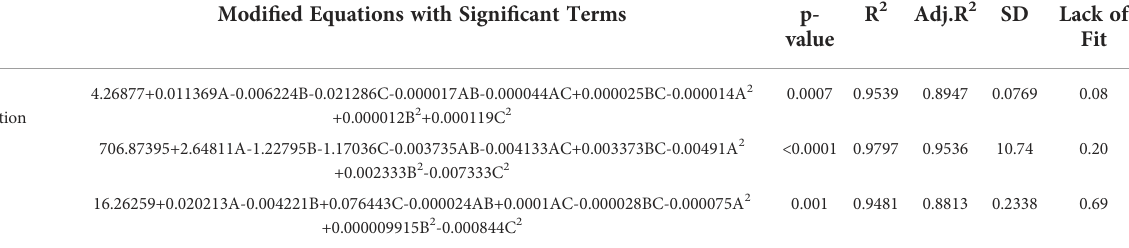
TABLE 3 Analysis of variance for the response surface